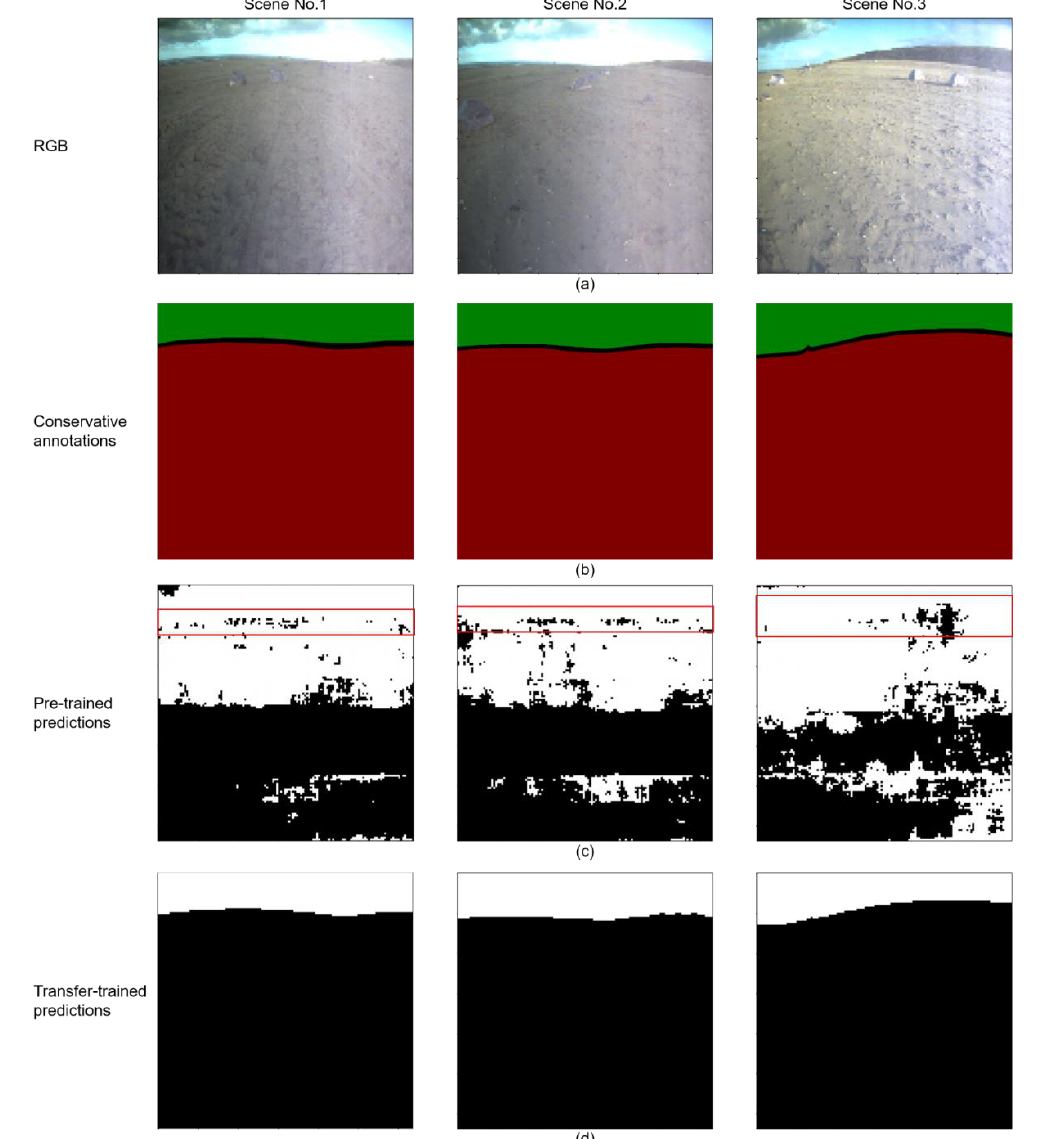
Figure 11. The visualizations of pre-trained and transfer-trained networks for three random scenes from the Katwijk dataset. ( a ) refers to the RGB input images from the Katwijk dataset. ( b ) refers to the corresponding conservative annotations from Section 2.3. ( c ) refers to the prediction from the pre-trained network in the Katwijk dataset. The red frames highlight the approximate skylines, and the white and black pixels have found the rough sky and ground regions. ( d ) refers to the results of the transfer-trained network. It is noteworthy that each column only correlates to a single scene.